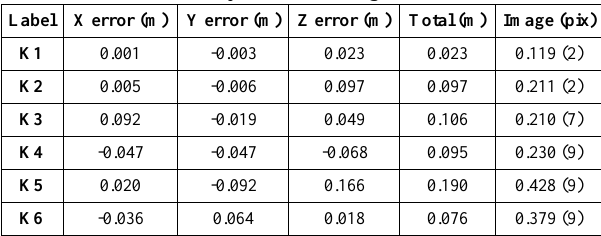
Figure 7. Positions of the ground control points of surveying area B The accuracy of aerial triangulation on the control points after bundle block adjustment is given by Table 2. The planar accuracy is at the level of centimetres and the vertical accuracy is at the level of decimetres. Table 2. Accuracy of aerial triangulation on